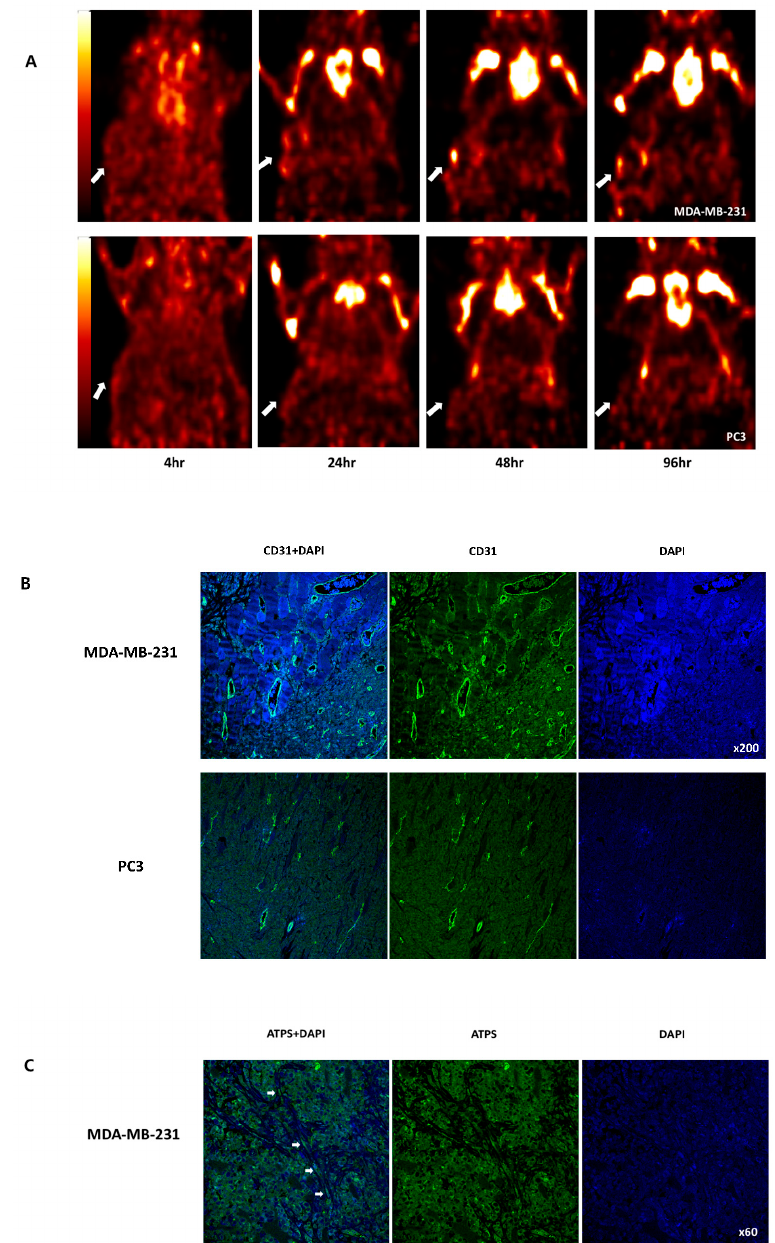
Figure 4. PET imaging for the biodistribution of Zr-89 ATPS mAb at 4, 24, 48, and 96 h in mice bearing MDA-MB-231 (upper) or PC3 (lower) tumors in the right flank ( A ). Confocal microscopy with anti-CD31 antibody for tumor angiogenesis imaging ( B ) and with ATPS mAb for visualizing the expression of ATPS on the endothelial cells. ATPS, adenosine triphosphate synthase; mAb, monoclonal antibody. Arrows indicate tumors ( A ) and endothelial cells ( C ).